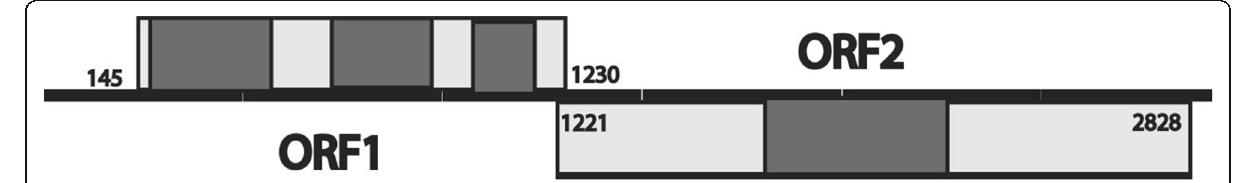
Fig. 2 Distribution of accumulated mutations observed in clones derived from SbDV-MD6 populations. The region sequenced extends from base 1 to base 2959 covering both ORF1 and ORF2 regions. Mutations are indicated by dark, and mutation free zones are white regions on the